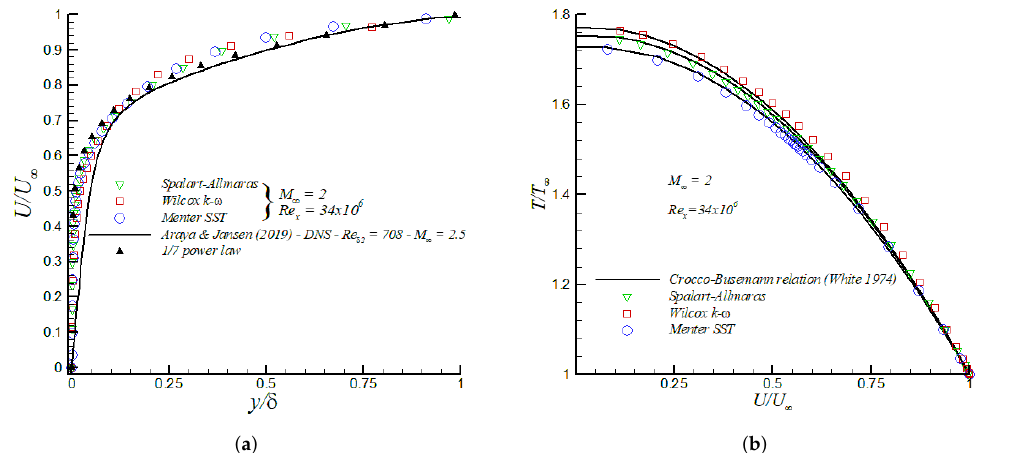
Figure 3. Mean streamwise velocity ( a ); and temperature distribution ( b ) in the supersonic flat plate.